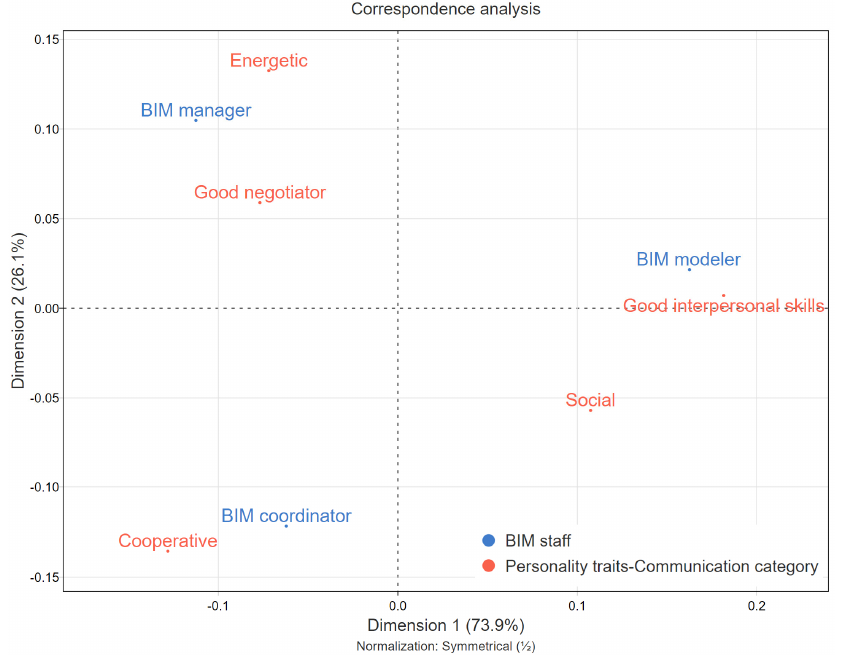
Figure 3. Comparison of the importance degree of personality traits (communication category) between BIM staff roles—Correspondence analysis.